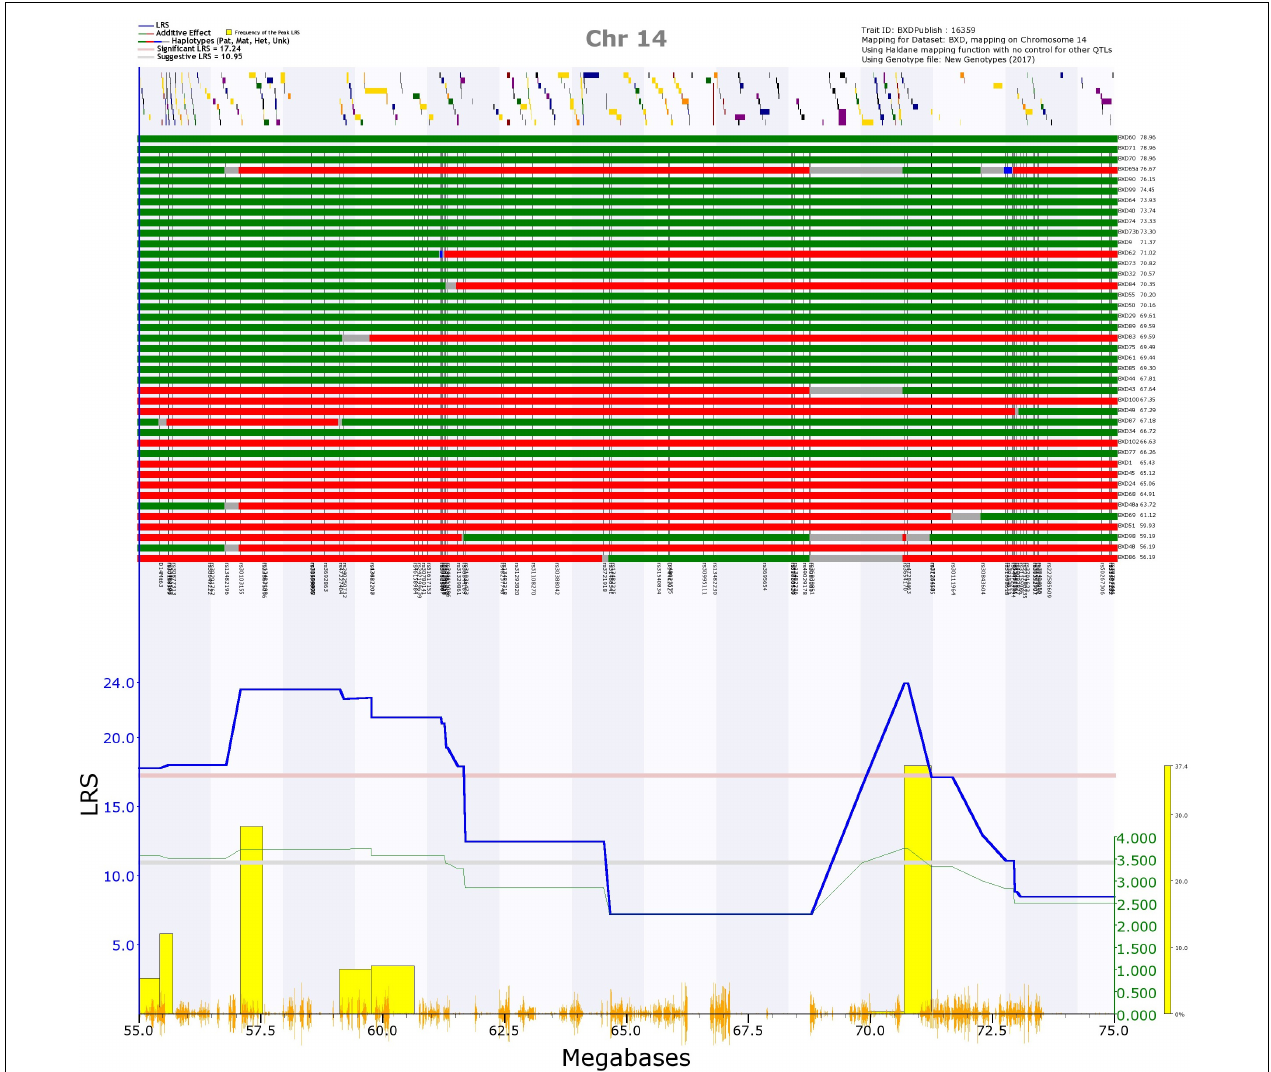
FIGURE 10 | QTL map of the Chr 14 QTL for trait 16359, frequency of calls on postnatal day 7. In the top section, the location of genes are shown by yellow and purple blocks. Below this, the distribution of haplotype blocks in the 41 BXD strains is shown. Green represents the D allele, whereas red represents the B allele. It is clear that the majority of strains with high values (i.e., a high call frequency, right of the top section) have the D allele (green), whereas the majority of strains with the B allele (red) have low values (i.e., a low call frequency, right of the top section). In the bottom section, the blue line represents the genome scan, showing the likelihood ratio statistic (LRS) associated with each marker across the locus. The top, pink, line marks genome-wide significance (genome-wide p ≤ 0.05), the lower, gray, line the suggestive significance threshold (genome-wide p ≤ 0.63). The green line shows the additive coefficient, showing that the DBA/2J alleles increase trait values. The green axis on the right shows by how much the respective alleles increase trait values. The yellow bars represent the bootstrap values, with the left edge of each bar showing where the peak fell in each of the 2,000 resamples of the data.